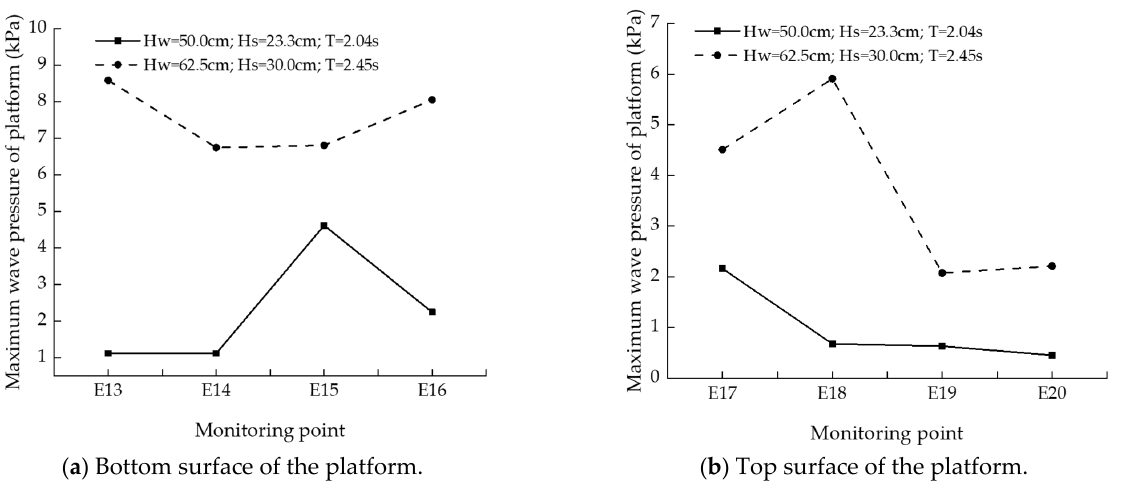
Figure 8. Diagram of wave pressure at different positions on the platform face.